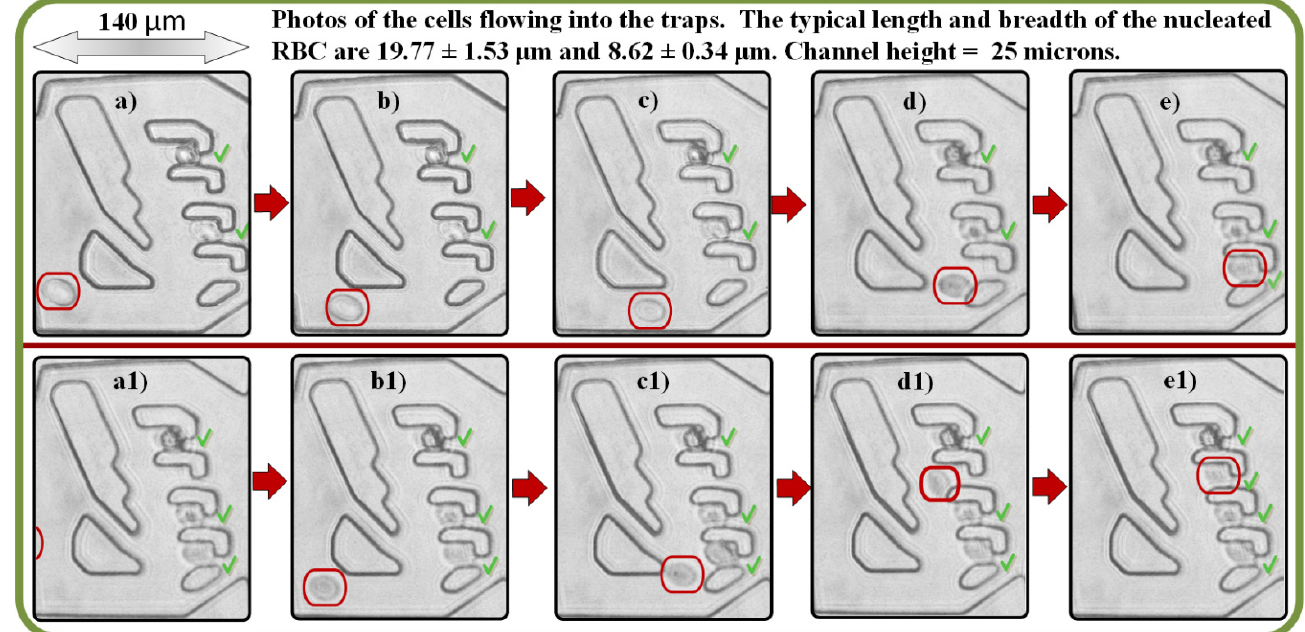
Figure 5. Experimental results of the prototype system following the evolutionary algorithm design to trap RBCs. The RBC cell approaching a trap is highlighted with the red oval. ( a – e ) Trapping of three living cells with one empty slot; ( a – d ) and ( a1 – d1 ) A single RBC is approaching the trap; ( e1 ) the trapping is completed with all 4 slots occupied by erythrocytes. Green “V”s mark the successfully trapped cells in each slot. Time elapsed images from ( a ) to ( e ) take 11 s and it takes 3 s from ( a1 ) to ( e1 ); photos made with objective ×20 with NA 0.45, camera Opax A3514DU3, and Motic MHG-100B microscope.